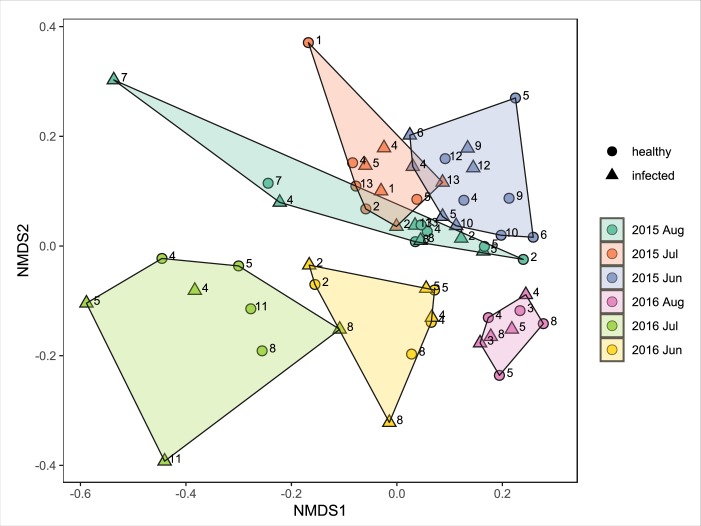
Biplot of Bray-Curtis dissimilarity of bacterial OTU abundances of teat skin swab samples from individual mammary glands by month of year and infection status of gland.Shape of points indicates infection status and color indicates sampling date. Paired infected and healthy samples collected from the same cow that visually cluster are indicated by an ellipse.